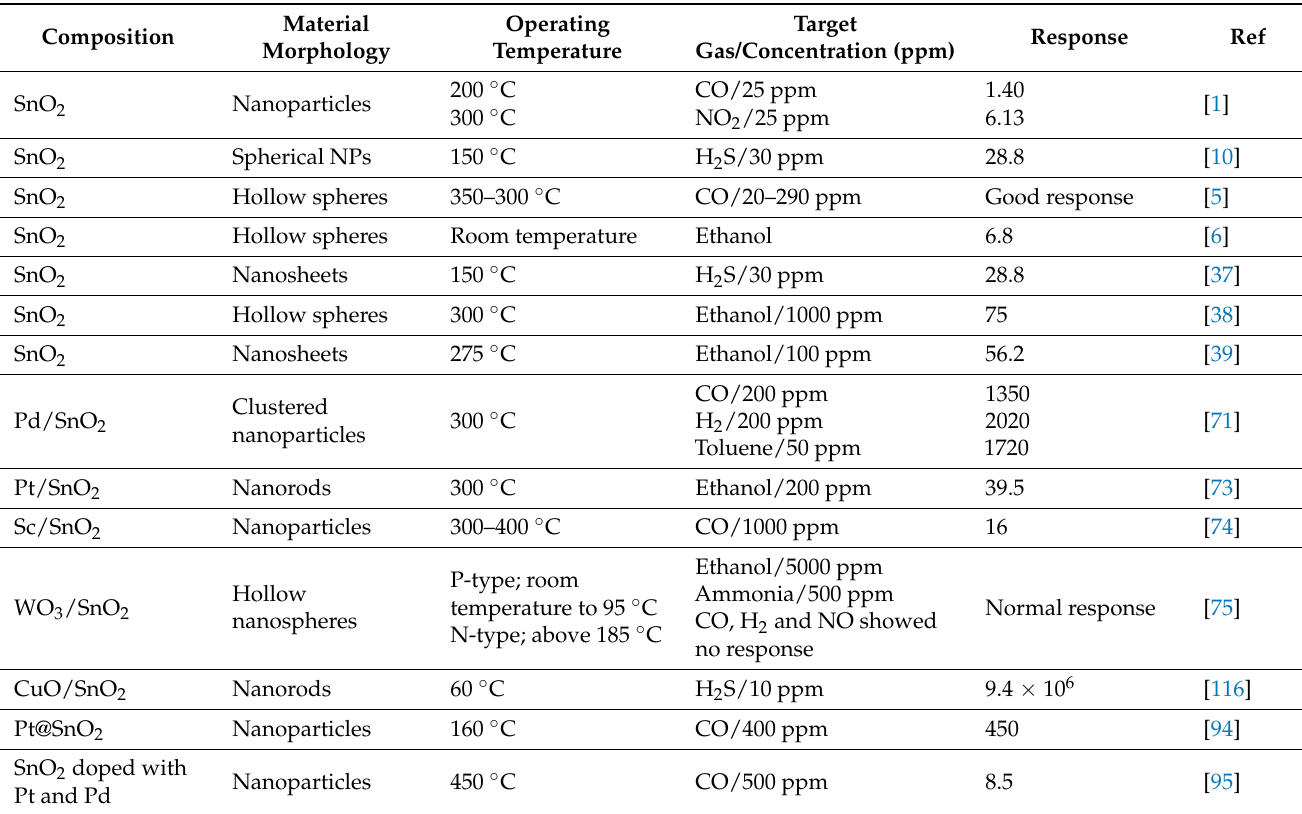
Table 3. Comparison of sensing performance parameters of SnO 2 -based gas sensors with different